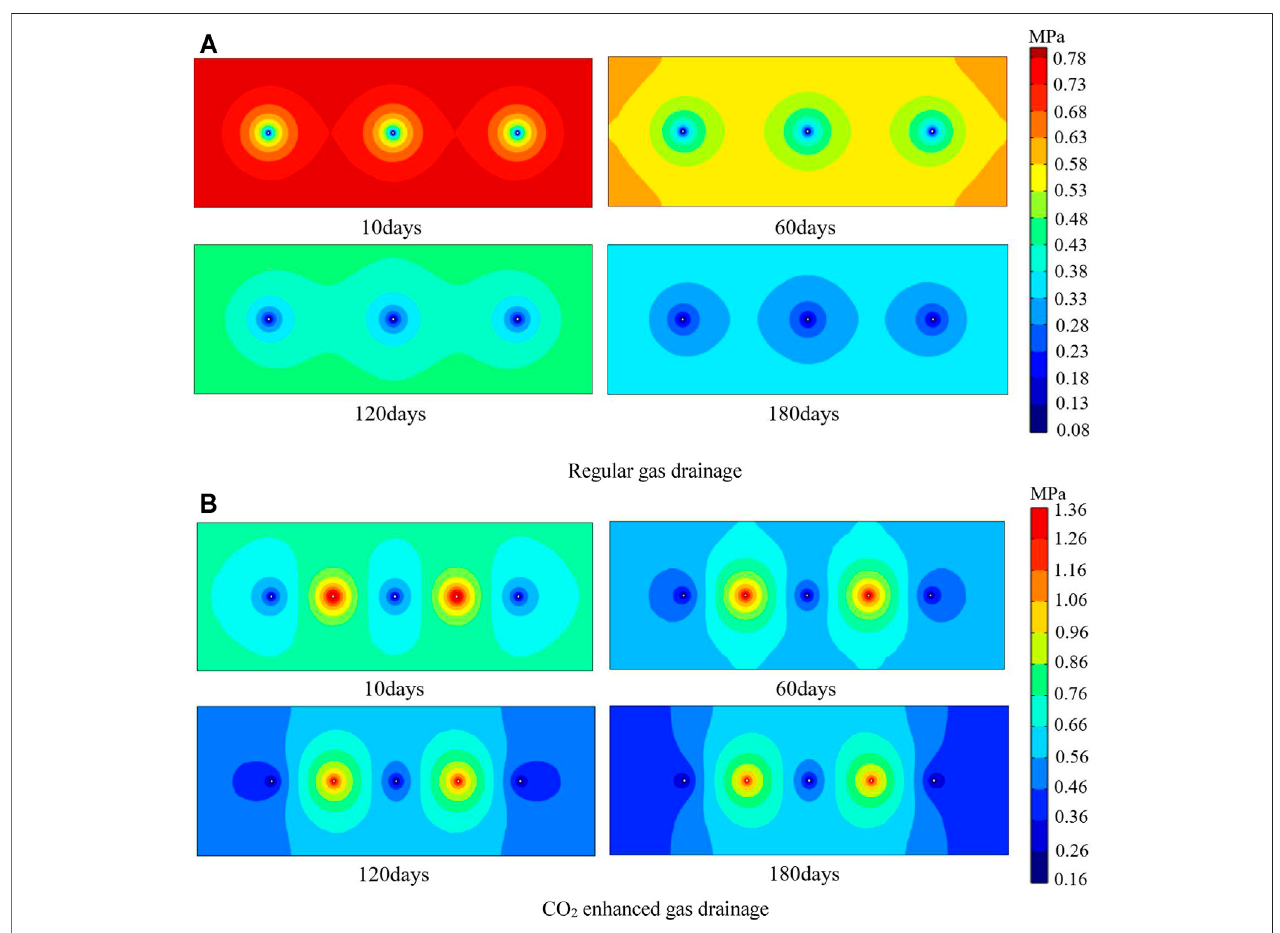
FIGURE3| CoalbedgaspressuredistributionofbothregularandCO 2 enhancedgasdrainageatdifferenttimes. (A) Regulargasdrainage. (B) CO 2 enhancedgas drainage.